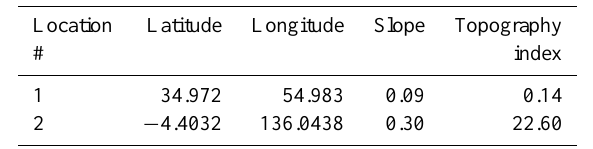
Fig.3. 24-hrprecipitationaccumulationsoverlandslideobservationpoints. Fig. 3. 24h precipitation accumulations over landslide observation